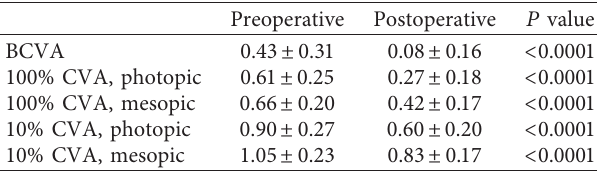
Table 3: Changes in BCVA and CVA ( n �